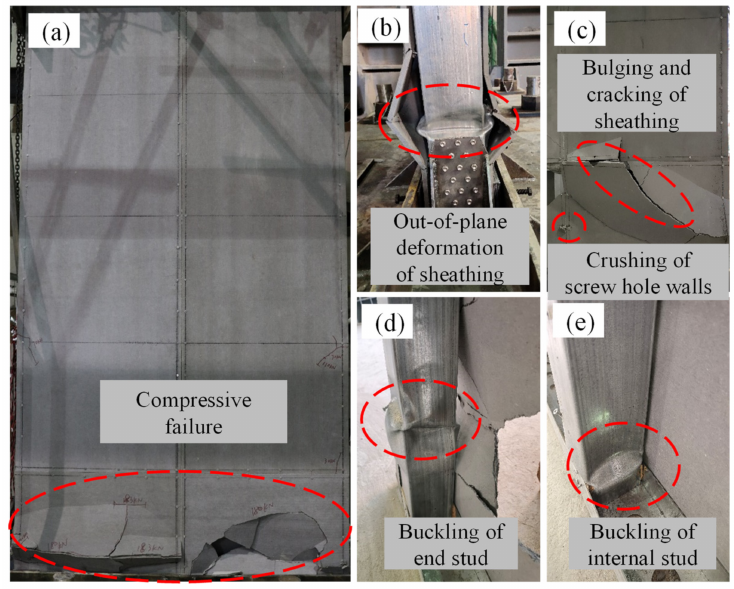
Figure 5. Failure of specimen